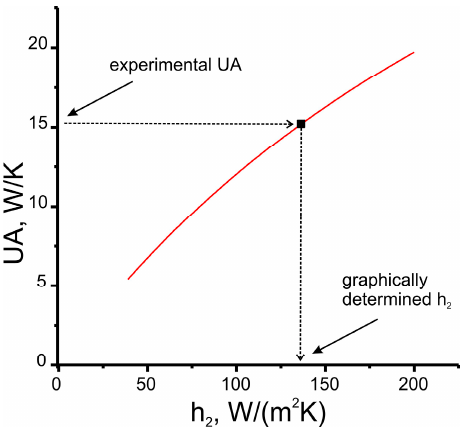
Figure A2. Dependence of global heat transfer coefficient UA of radiator R2 on heat transfer coefficient h 2 (red line) and element of experimental dataset (symbol). Arrows illustrate the principle of graphical solving of h 2 = function − 1 (UA).